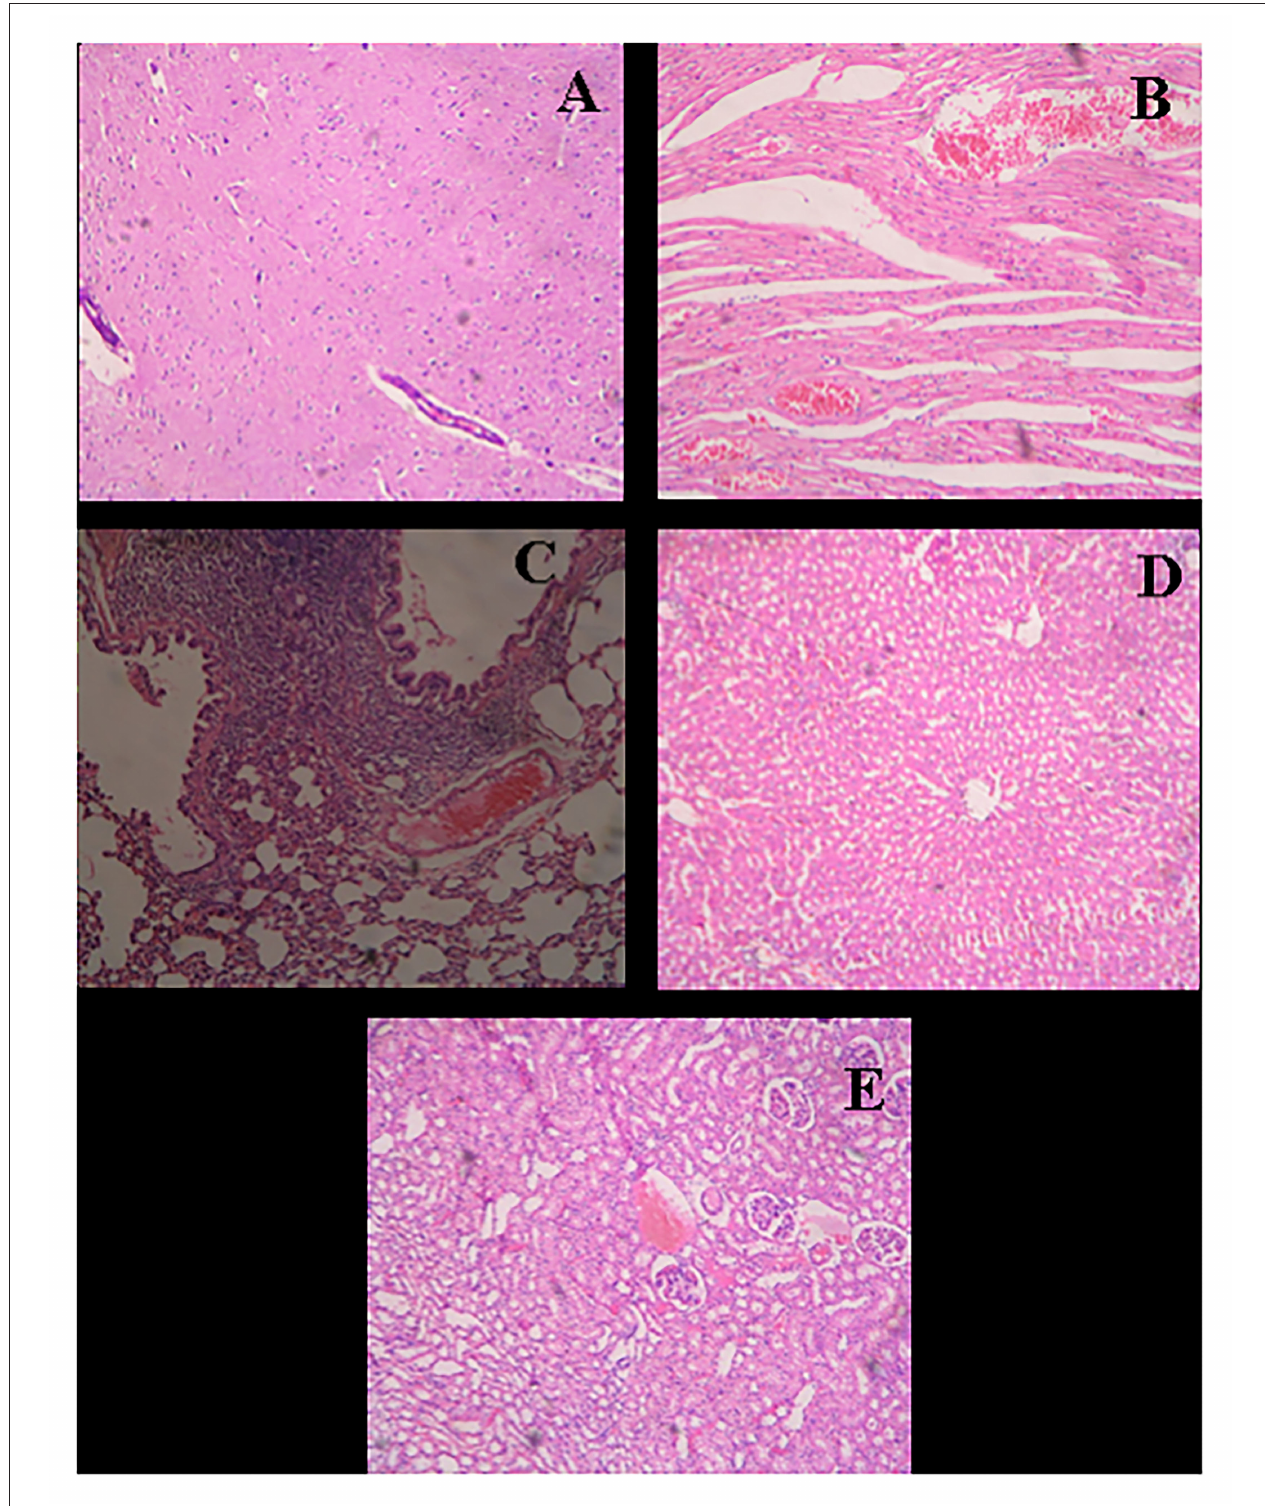
FIGURE 8 | Histological micrograph of organ’s tissue after wound-healing study (Group F- Control). (A) Section of brain tissue showing normal parenchyma; ( B) Section of heart tissue showing severe congestion in myocardia; (C) Section of lung tissue showing emphysema, round cell infiltration, and imperial bronchiolar congestion; (D) Section of liver tissue showing mild congestion and periportal round cell infiltration; (E) Section of kidney tissue showing congestion, infiltration, and vacuolar changes in proximal tubule (at a resolution of 40 × ).